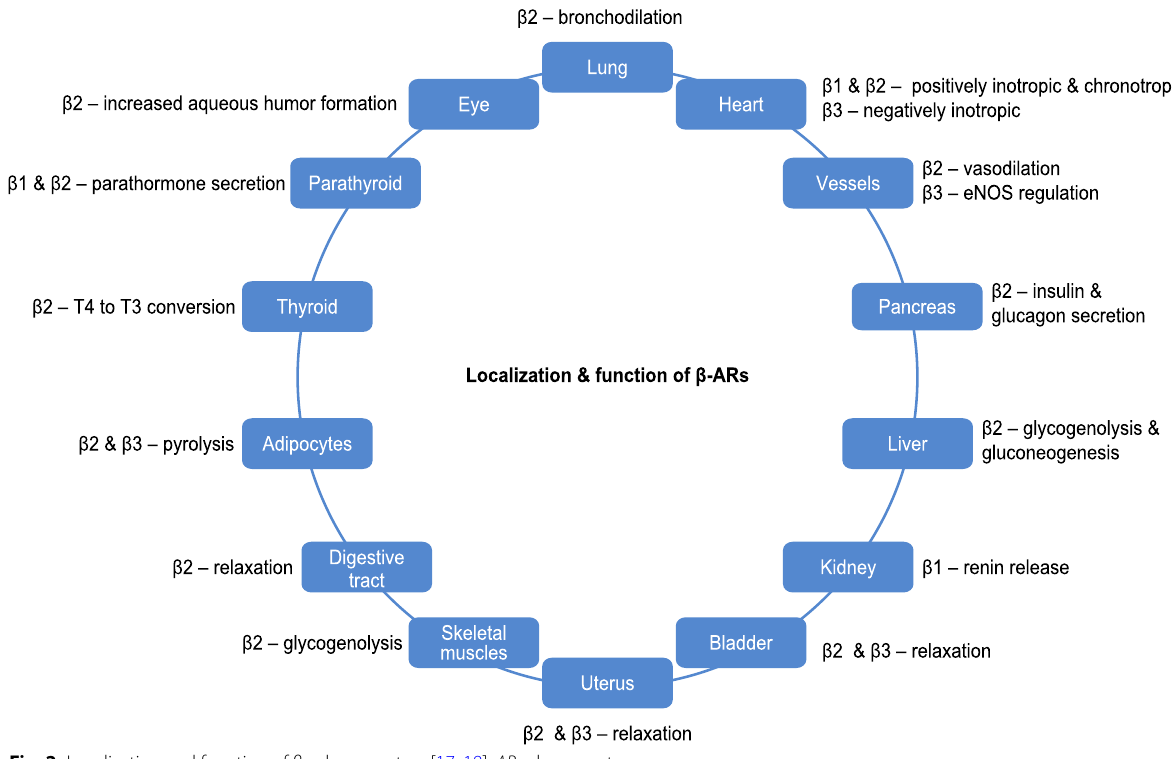
Fig. 2 Localization and function of β‑adrenoceptors [17, 18]. AR adrenoceptors